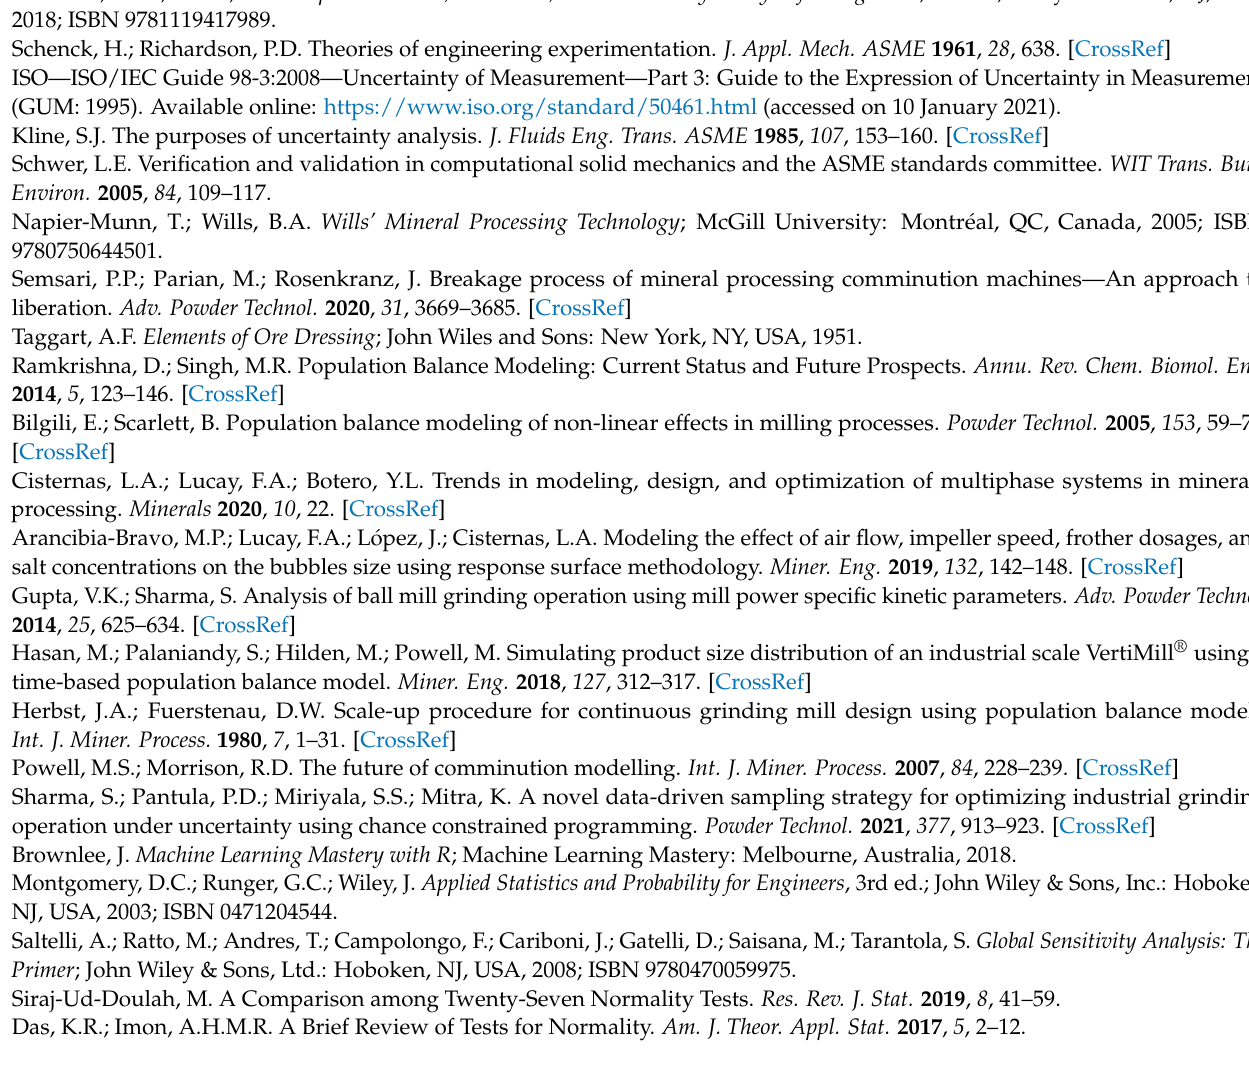
Figure A6. Cross-correlation analysis for 12 min grinding; ( a ) WPES; and ( b ) PSD.